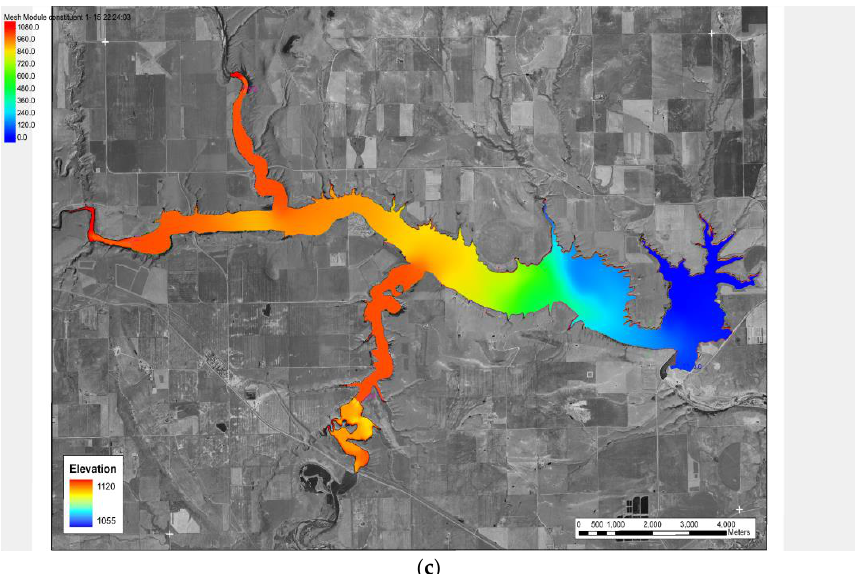
Figure 11. Simulation of sediment propagation through the Oldman Reservoir as predicted by TABS-MD (( a ) Elapsed time = 2 days; ( b ) Elapsed time = 8 days; ( c ) Elapsed time = 16 days). The elevation legends shown as insets in these figures need to be ignored.